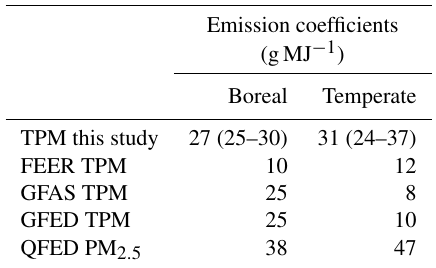
Table 2. Total particulate matter emission coefficients derived